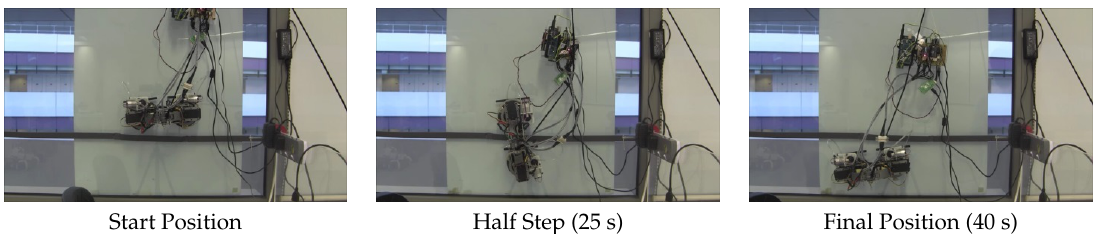
Figure 16. Snapshots of the overcoming obstacles experiment with time variation. Obstacles were overcome within 40 s without any human